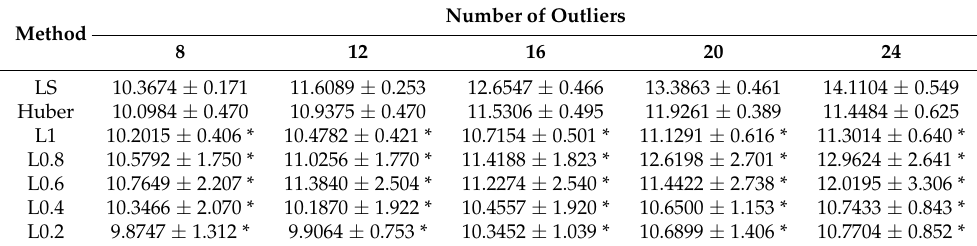
Table 4. Fitting errors of the TISO system with different numbers of outliers.